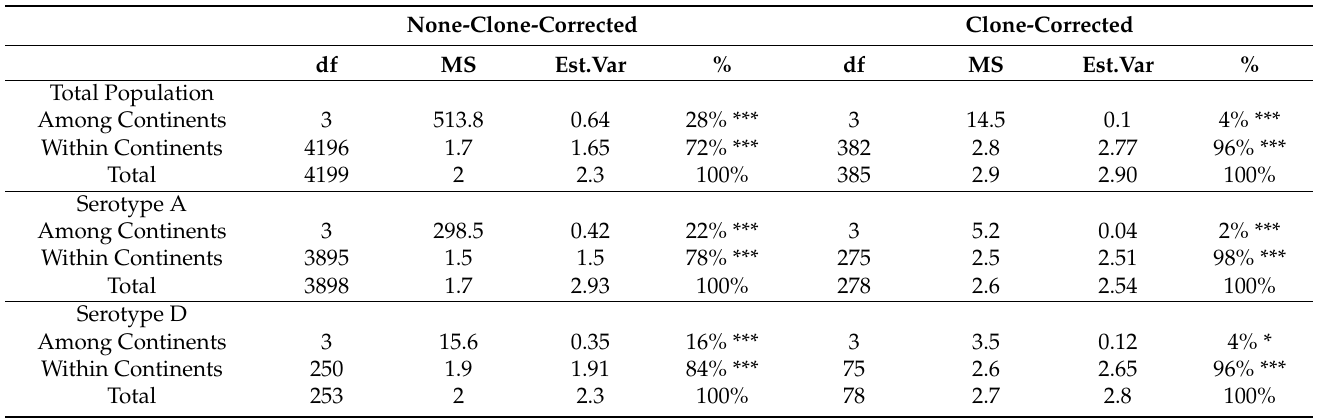
Table 5. Analysis of molecular variance at the continental